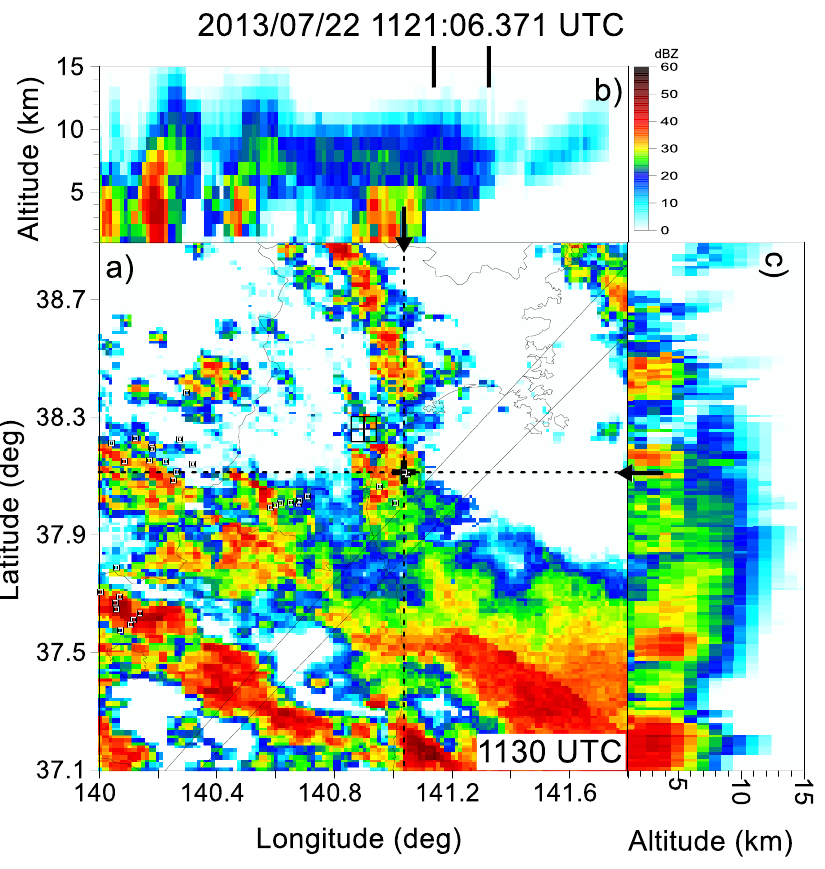
Figure 7. The horizontal and vertical cross-sections of the parent MCS with respect to Sprite 2 at 1121:06.371 UTC. The descriptions ( a – c ) are the same as in Figure 6.